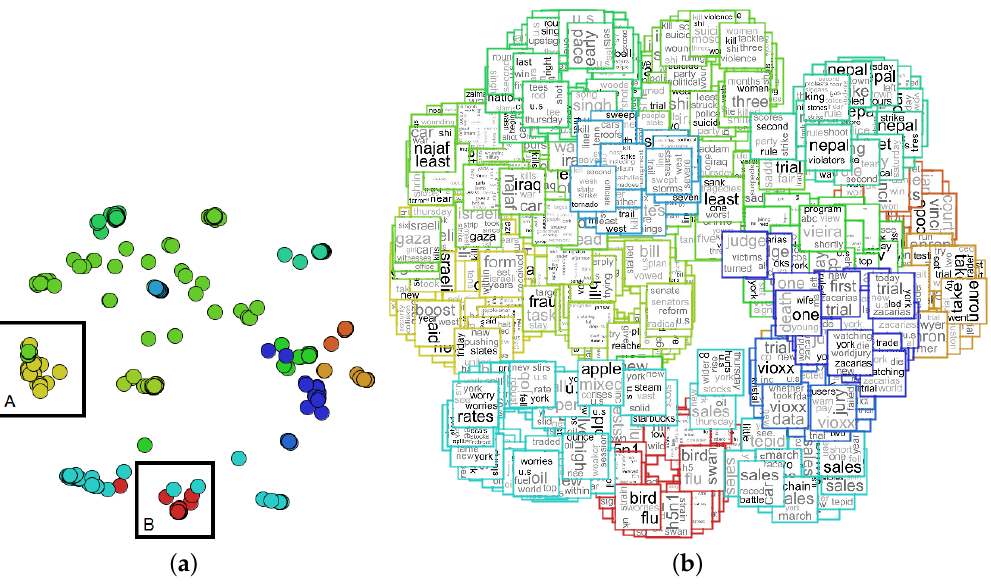
Figure 6. Analysis of the NEWS-13 dataset: ( a ) a 2D projection of the document collection and ( b ) the tag cloud of each document as a visual